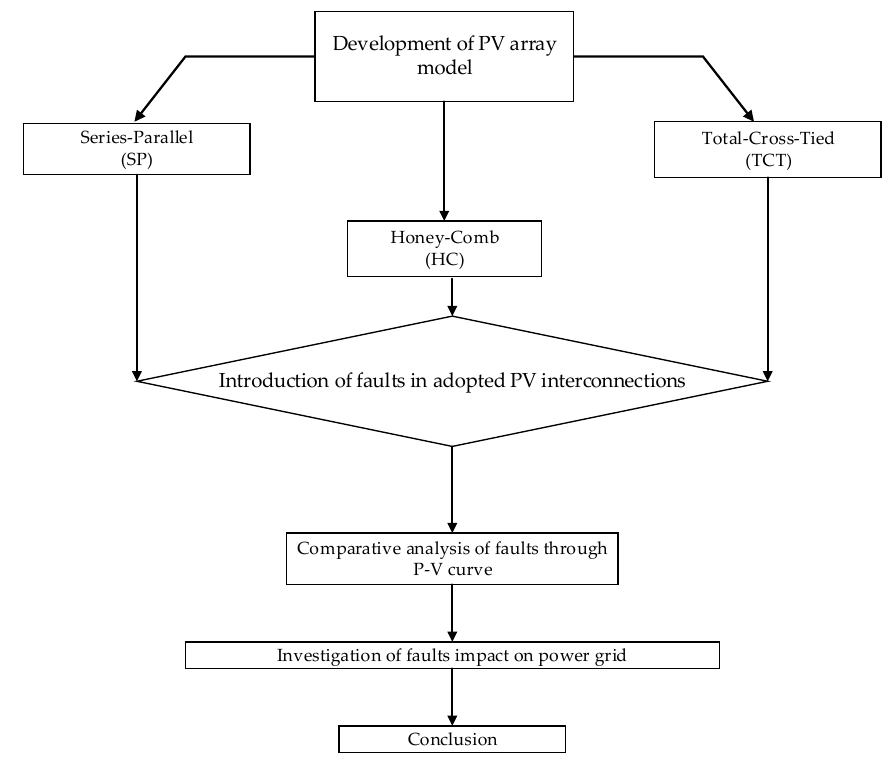
Figure 3. Flow chart of proposed methodology.